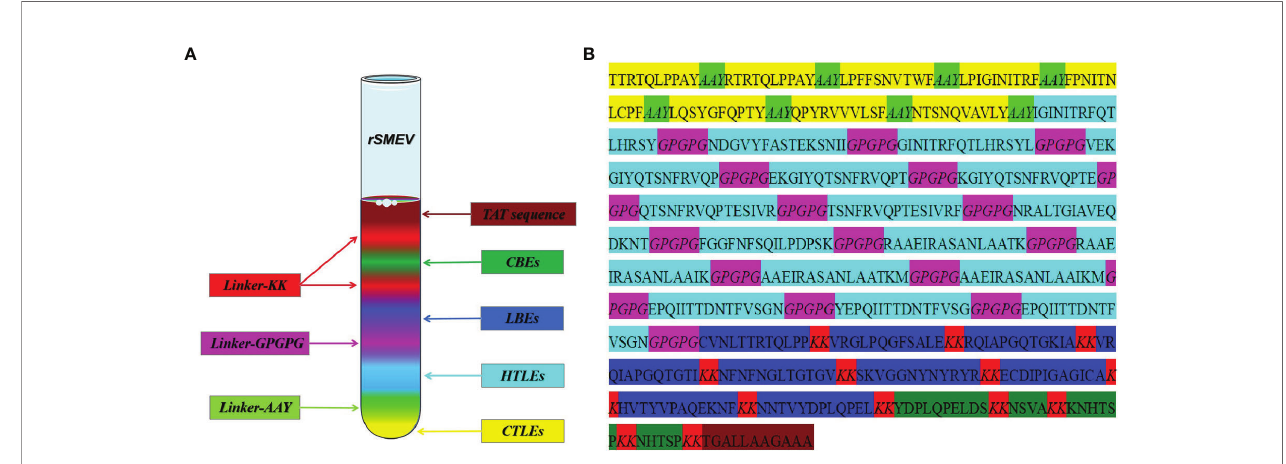
FIGURE 8 | The design and construction of rSMEV . (A) Schematic diagram of all the components needed in vaccine construction, and the different colors represented different epitopes and linkers. (B) The speci fi c amino acid sequence of all the epitopes and linkers required for vaccine construction, and the color of each part corresponded to the color in the (A)